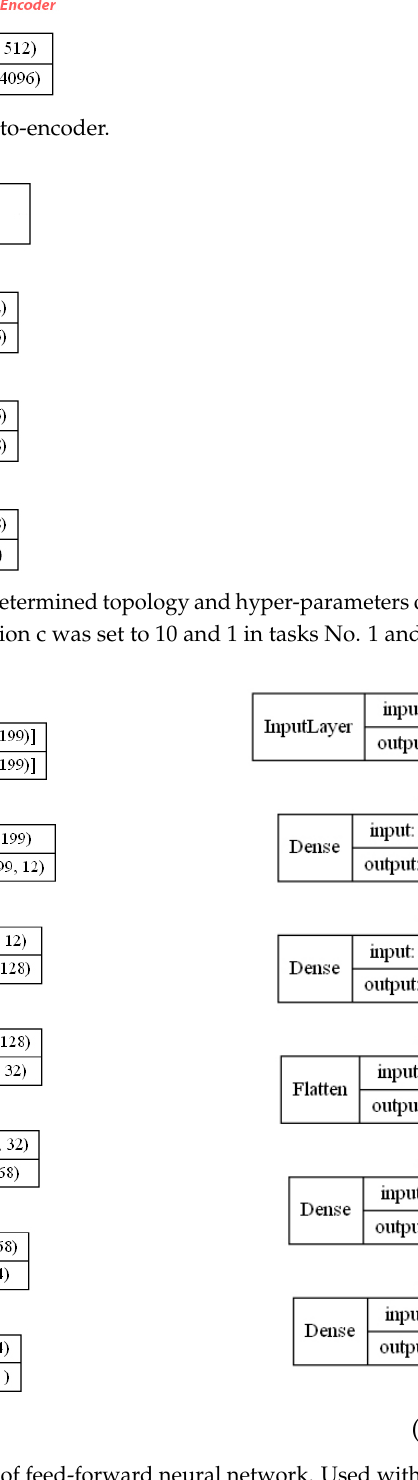
Figure A5. The topology of feed-forward neural network. Used with LE vectorization ( a ), with ECFP vectorization ( b ).